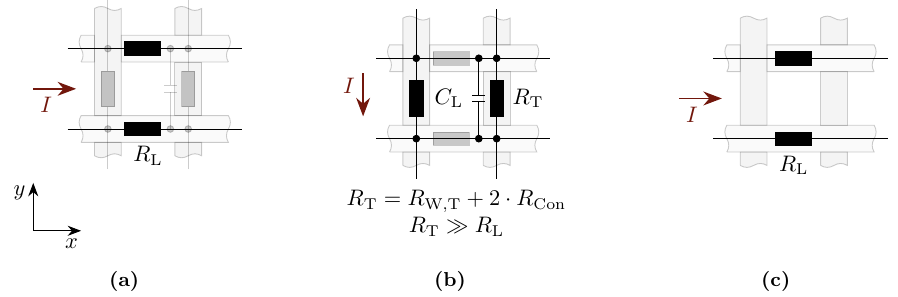
Figure 5. Impedance model for determining the electrical resistivity ρ e,M or the electrical conductiv- ity σ e,M of metallic wire mesh: ( a ) Impedance model in the longitudinal direction, ( b ) impedance model in the transverse direction and ( c ) simplified impedance model for the analytical